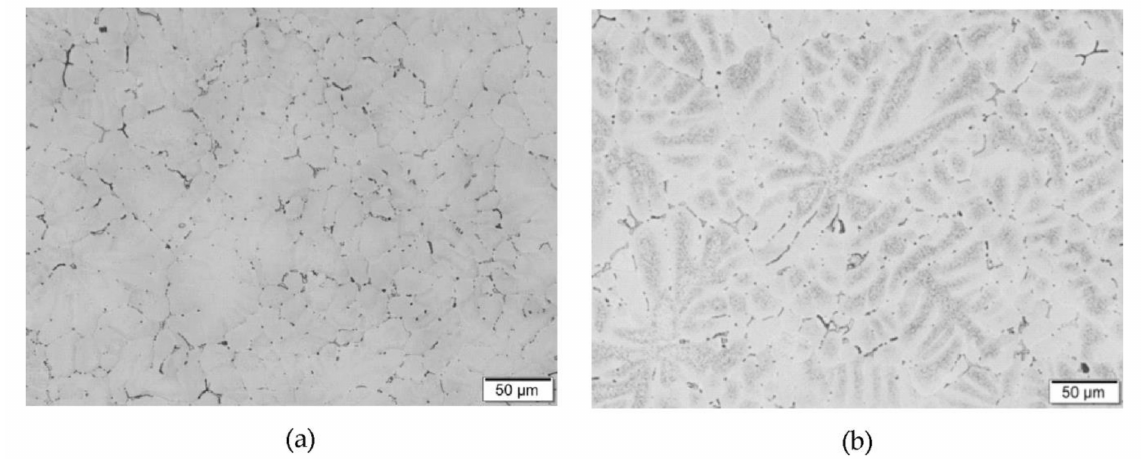
Figure 6. Exemplary microstructure of 7075 alloy 3 after homogenization: ( a ) soaking at 465 ◦ C for 2 h; ( b ) soaking at 475 ◦ C for 4 h (visible dispersoids reflecting former dendritic